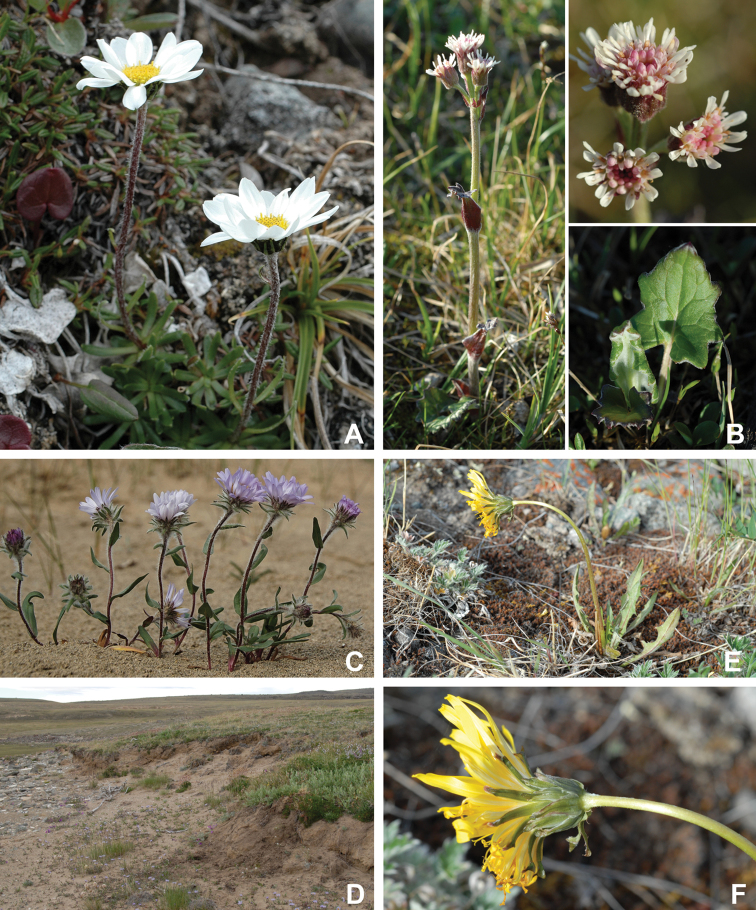
AHulteniella
integrifolia habit, Minto Inlet, NT, 2 July 2010 BPetasites
frigidus
subsp.
frigidus habit (left), inflorescence, (upper right) and basal leaf (lower right), Gillespie et al. 9752CSymphyotrichum
pygmaeum habit, Gillespie et al. 9883DSymphyotrichum
pygmaeum habitat, Gillespie et al. 9883ETaraxacum
ceratophorum habit, Gillespie et al. 9745FTaraxacum
ceratophorum inflorescence, Gillespie et al. 9745. Photos A, C by R.D. Bull and B, D–F by L.J. Gillespie.